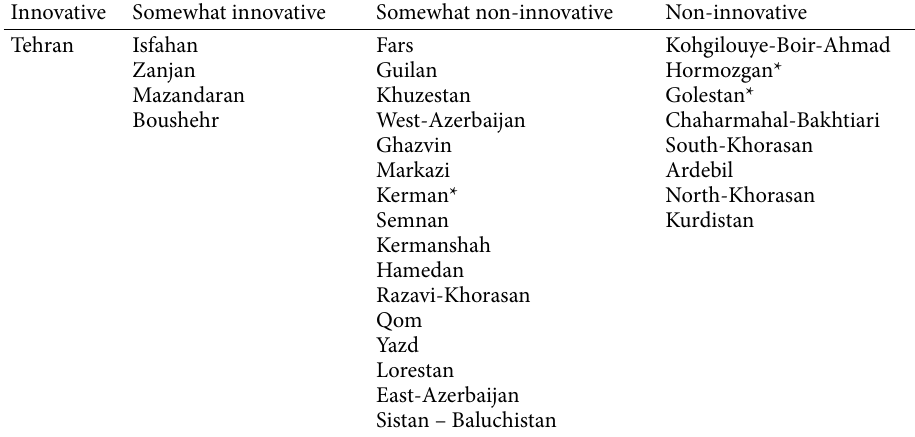
Table. Innovativeness classification of Iran’s provinces Innovative Somewhat innovative Somewhat non-innovative